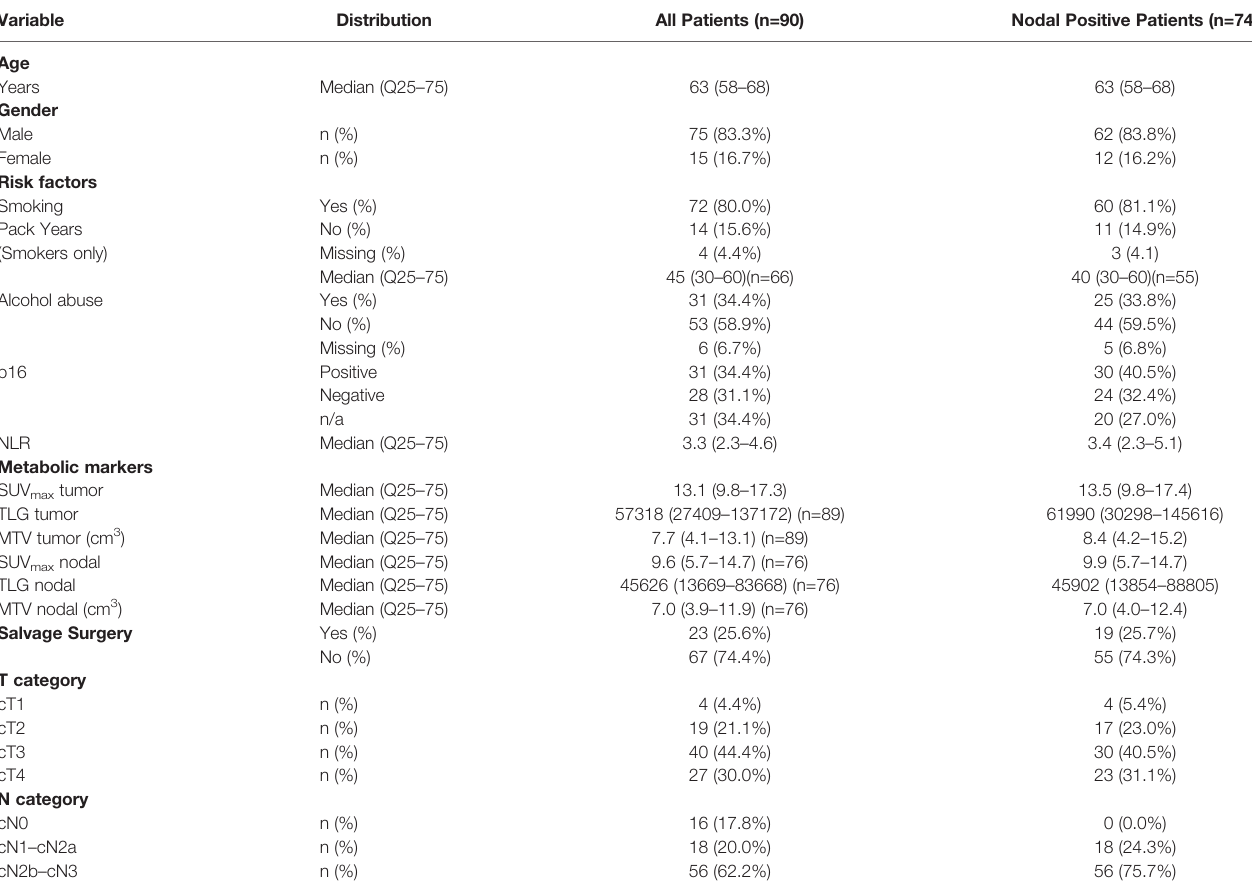
TABLE 1 | Patient demographics and clinical